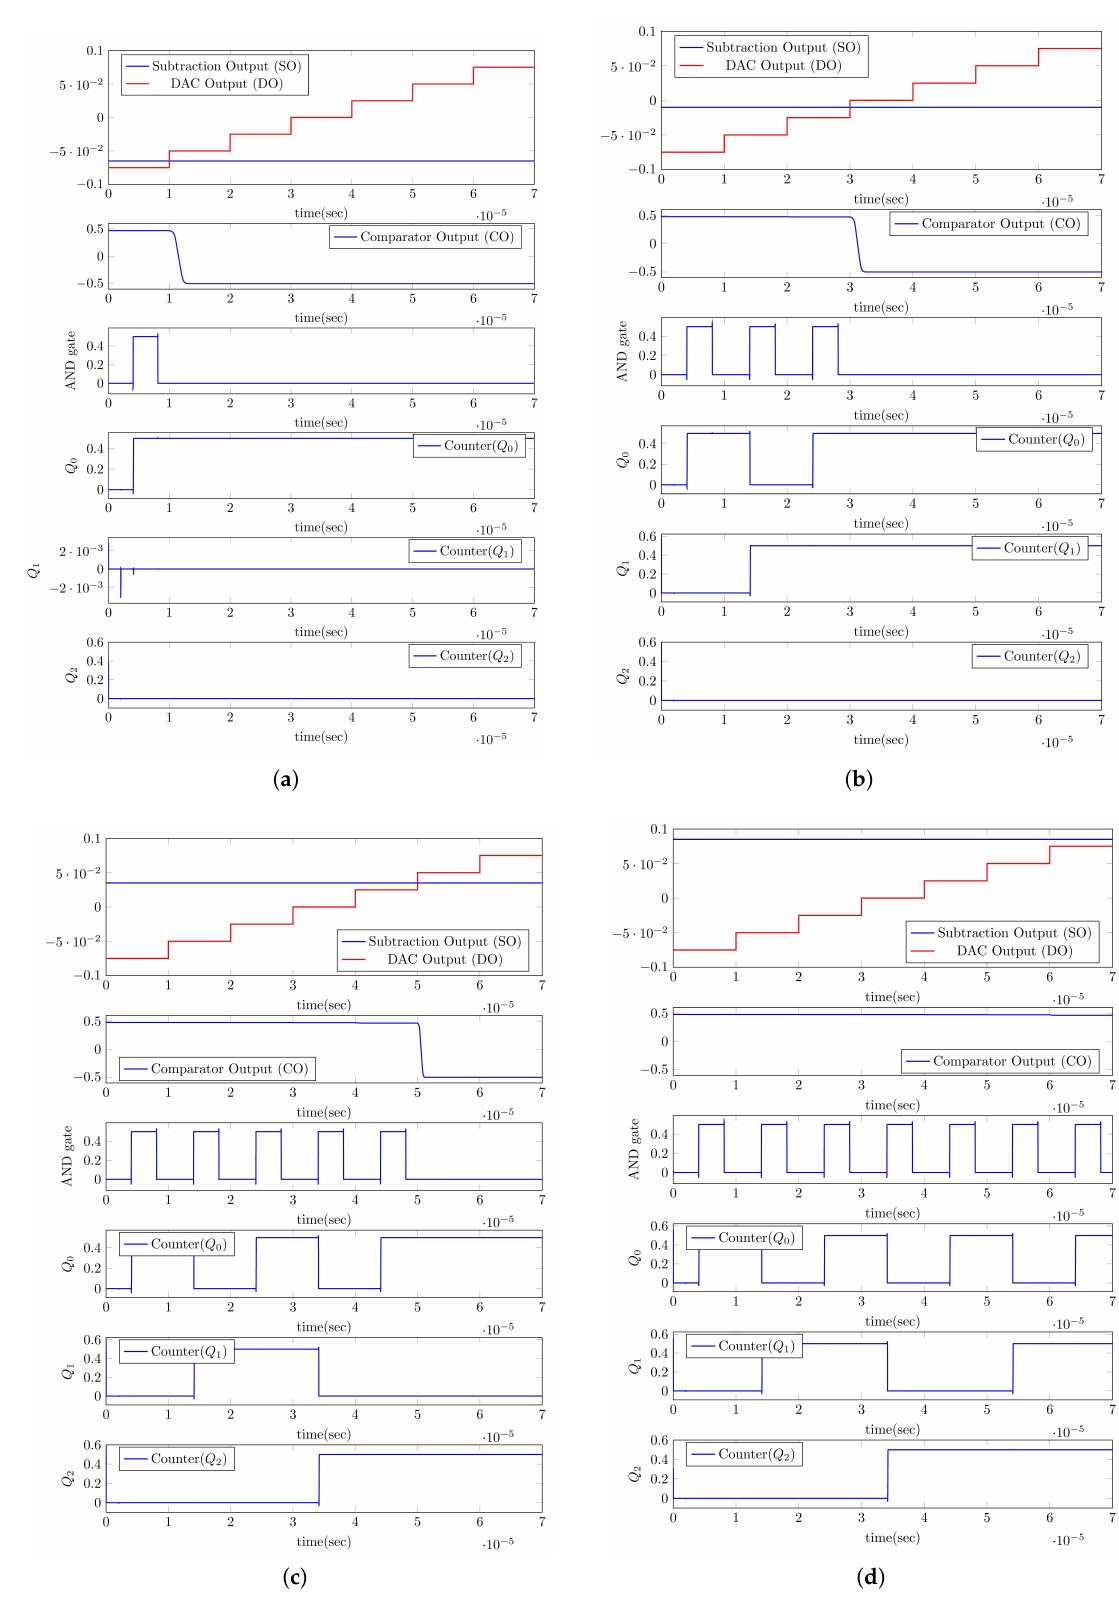
Figure 9. Calibration output waveform when residual voltage is positive. ( a ) When − 75 mV < V r < − 50 mV. ( b ) When − 25 mV < V r < 0 mV. ( c ) When 25 V < V r < 50 mV. ( d ) When V r > 75